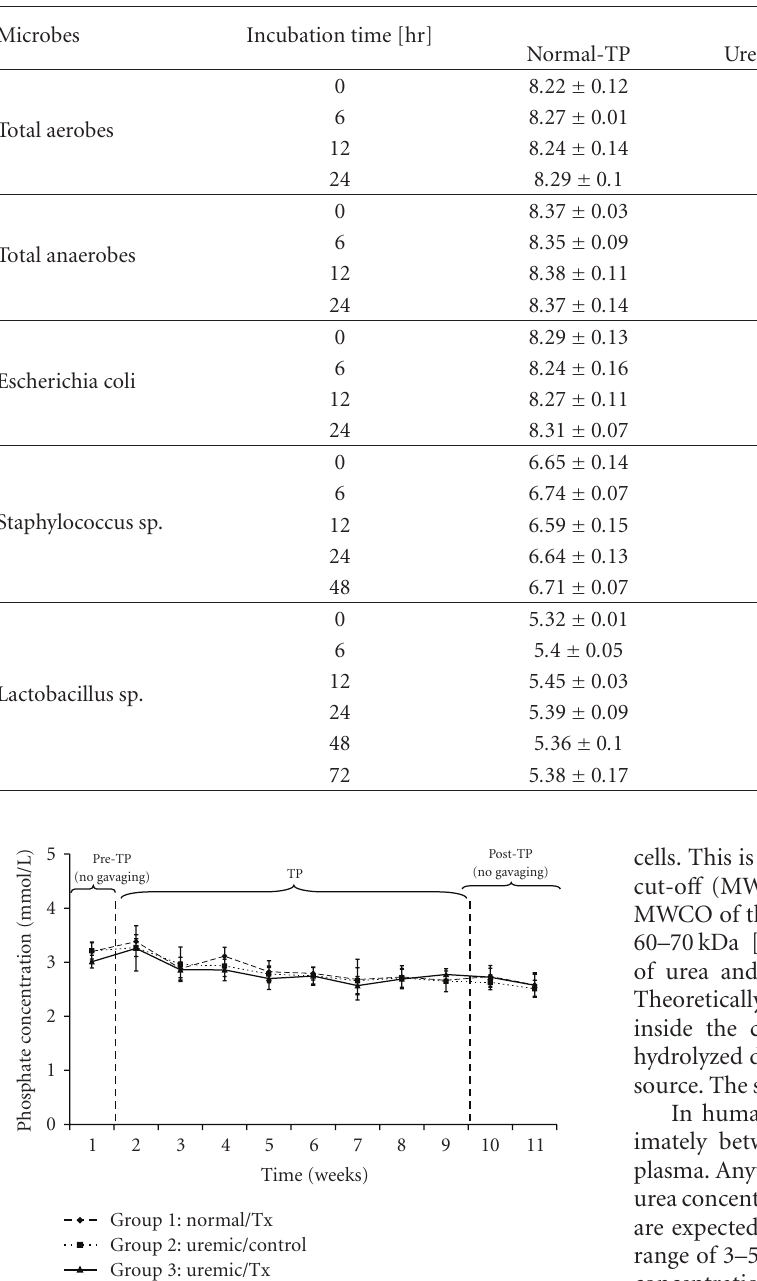
Table 2: E ff ect of APA microcapsules on selected microbes in the human large intestine.